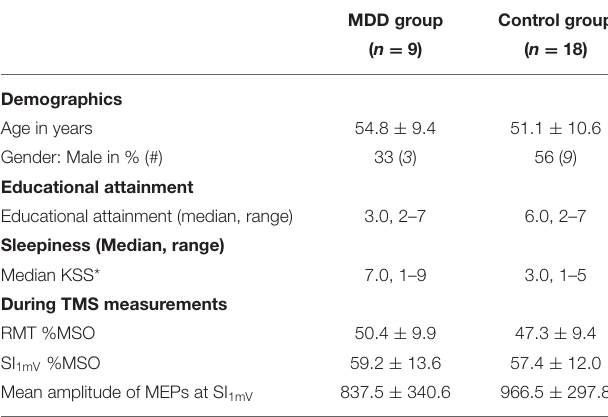
Age was not significantly different between the patient group TABLE 2 | Demographics, educational attainment, and variables during transcranial magnetic stimulation (TMS) measurements (Mean ± SD) of the major (M = 54.8 ± 9.4) and the control group (M = 51.1 ± 10.6) depressive disorder (MDD) group and the control group ( t age (25) = − 0.9, p = 0.4). Gender was not significantly = 1.2, p = 0.3). The different between the groups ( χ 2 gender